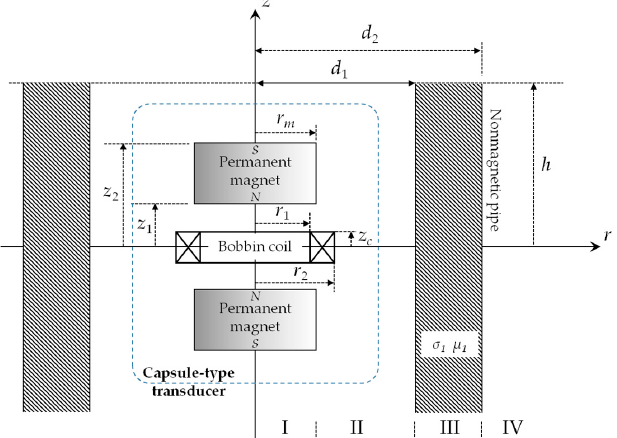
Figure 3. The 2D axi-symmetric model for Extended Truncated Region Eigenfunction Expansion (ETREE) modeling with the proposed capsule-type electromagnetic acoustic transducer.